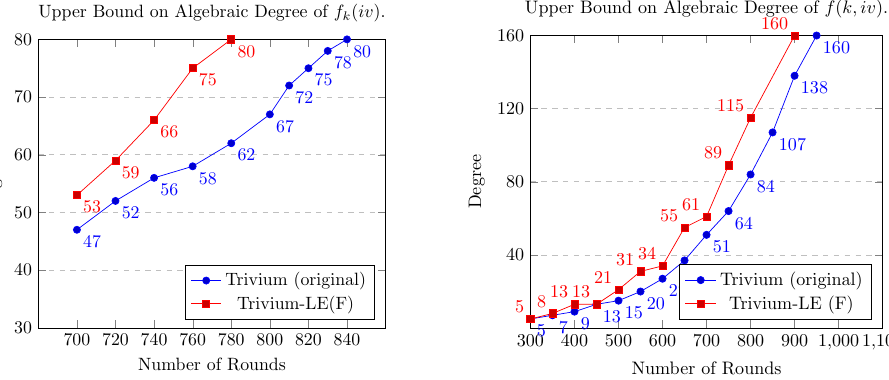
Figure 12: Increase in algebraic degree with respect to the #initialization